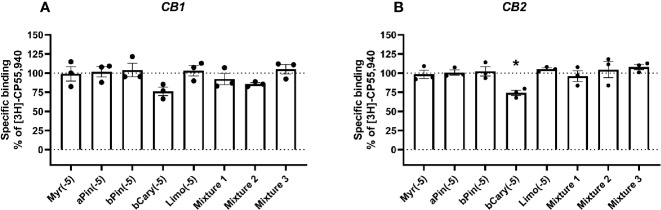
Specific binding of [3H]-CP55,940, with displacement by terpenes (10 µM) in membranes containing hCB1 (A) or hCB2 (B). Binding data in all plots are normalized to total [3H]-CP55,940 binding in the absence of displacer (100%), and in the presence of 10 µM THC (0%). Data are means ± SEM of three independent determinations. *p < 0.05.